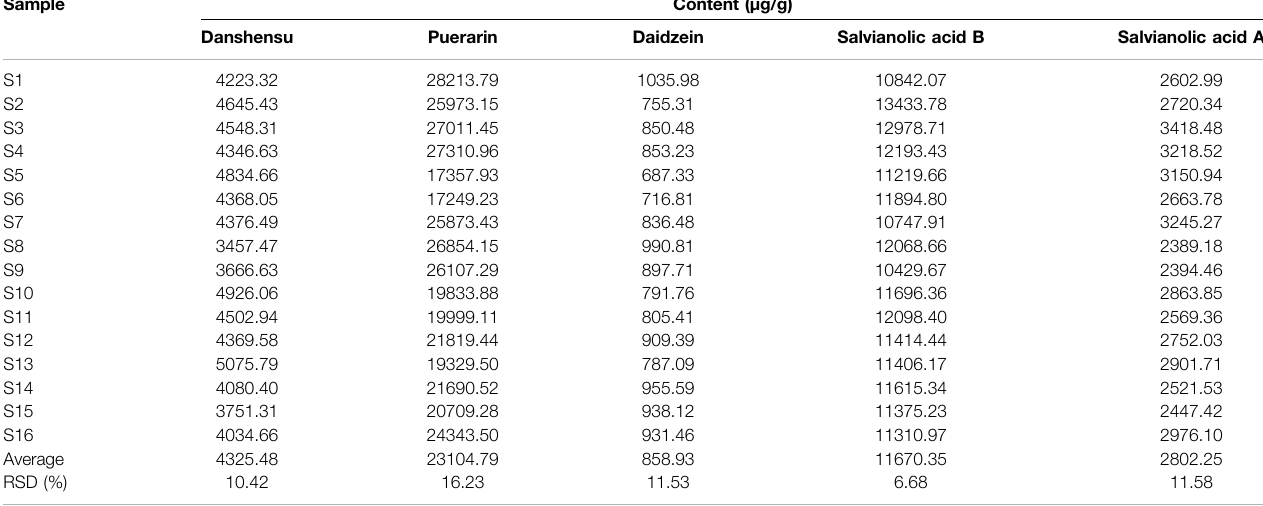
TABLE 5 | Contents ( μ g/g) of quality markers of